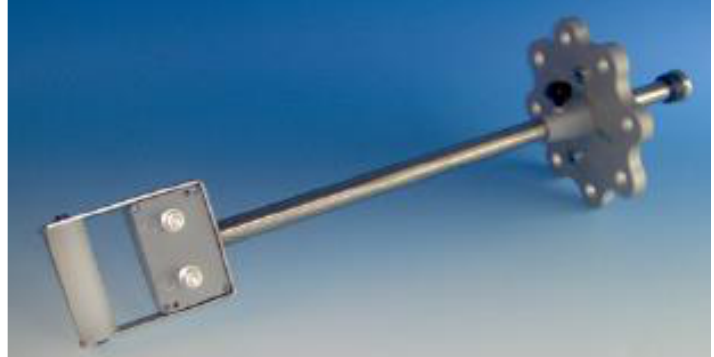
Figure 3. An image of the UHF drain valve sensor [4].